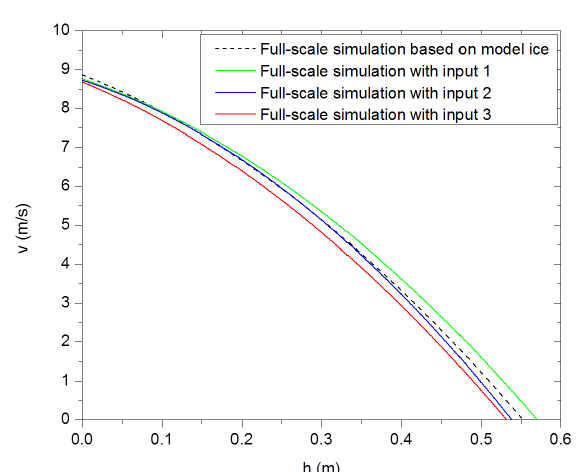
Figure 28: h − ν curve obtained when the vessel is run- ning ahead (the full-scale simulation results with different ice parameters).